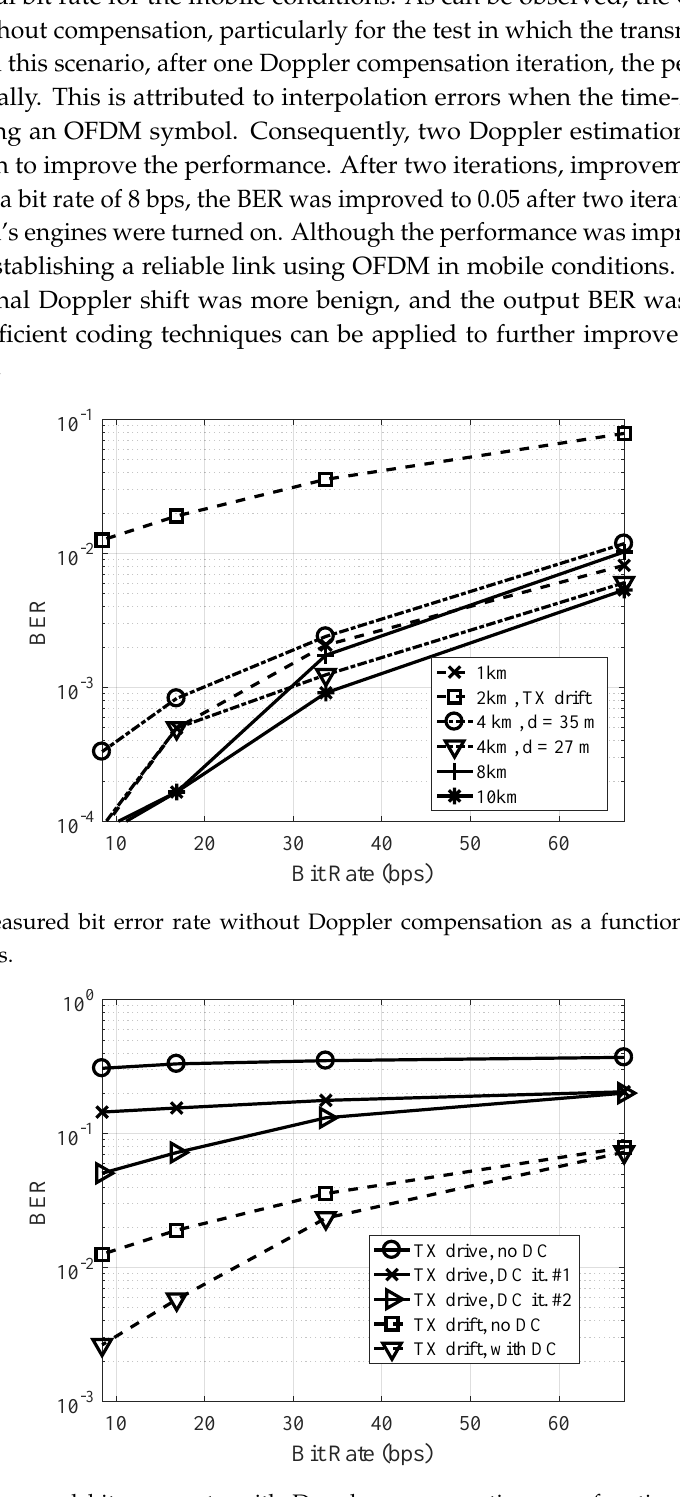
Figure 15. Measured bit error rate with Doppler compensation as a function of data rate for mobile